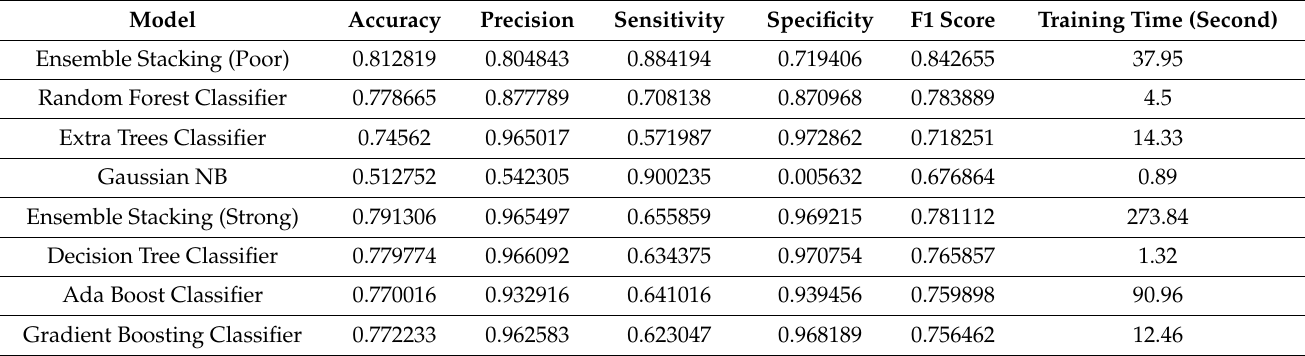
Table 5. Cyberattack detection using ensemble stacking for 20% of the NSL_KDD dataset.